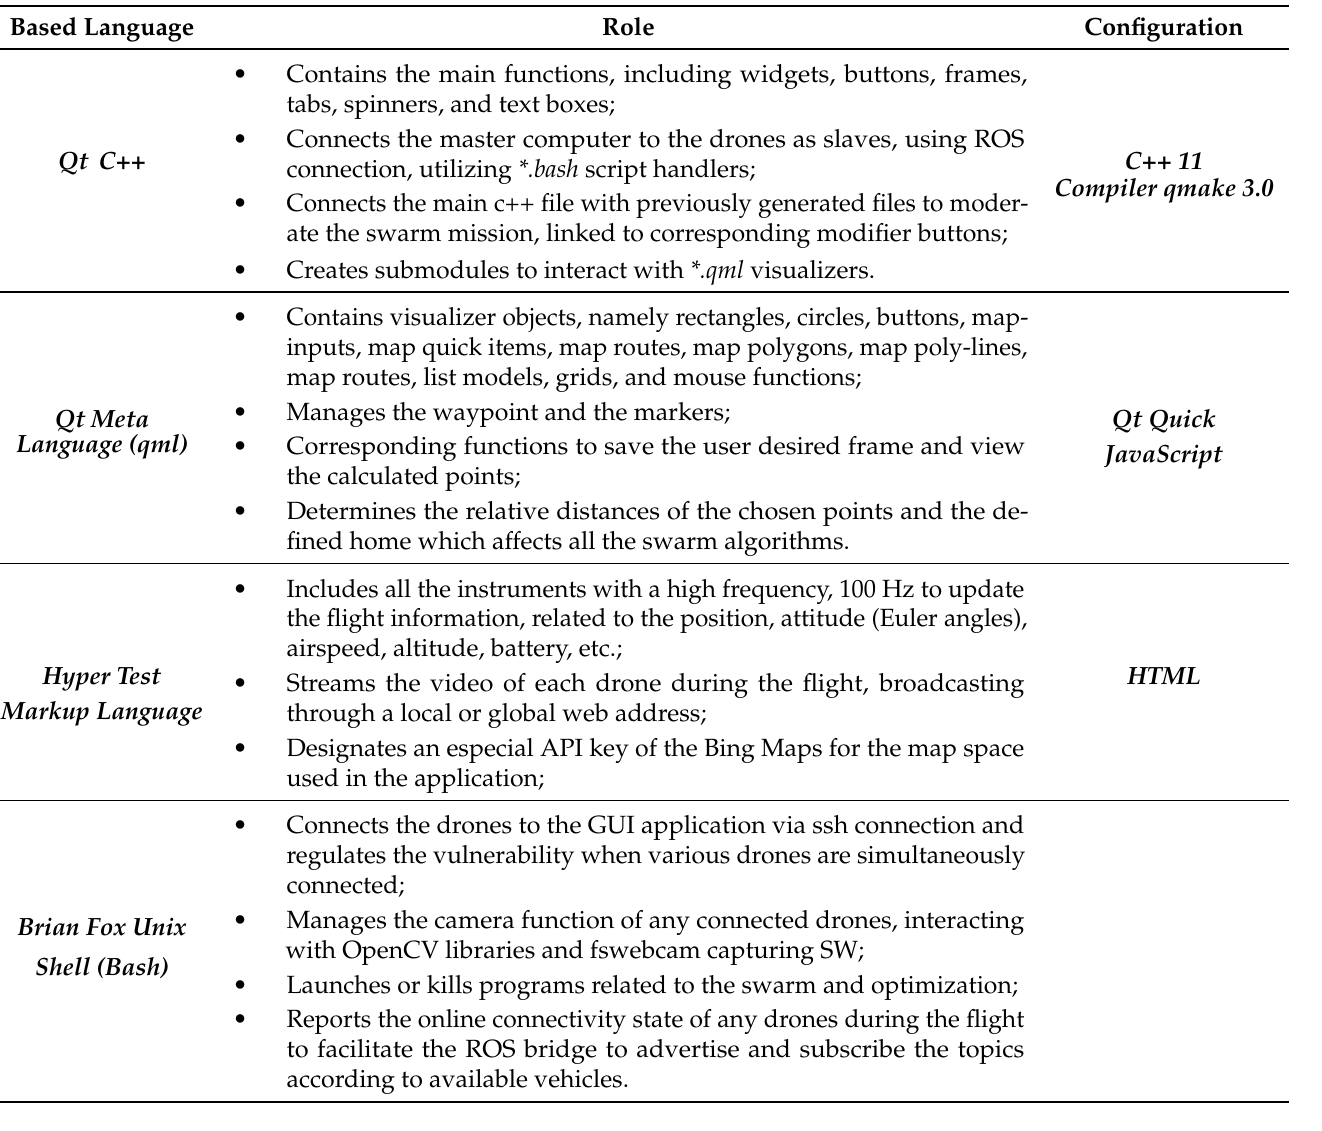
Table 1. Full properties of the swarm GUI